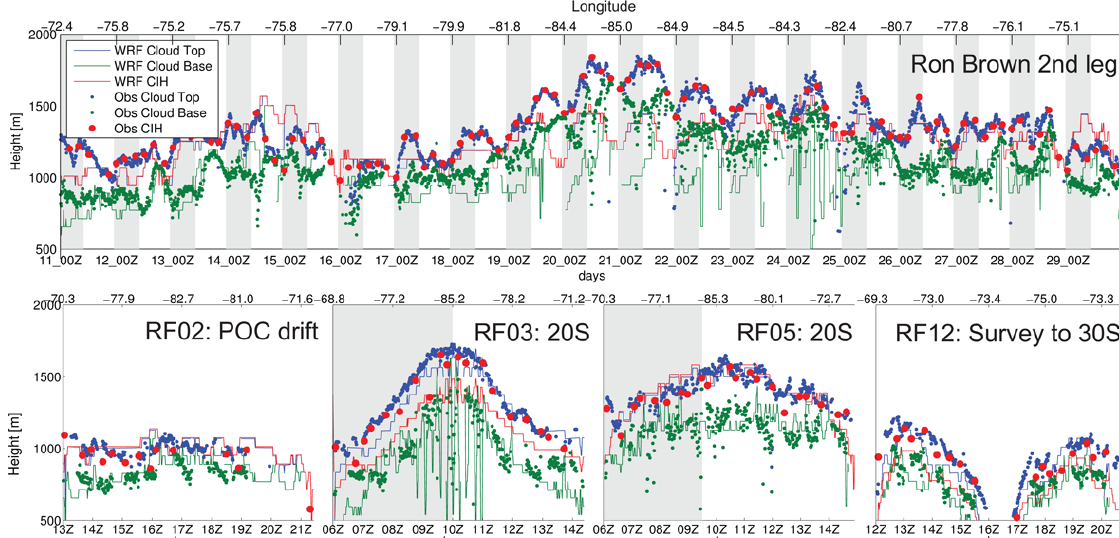
Fig. 4. Observed and NW model cloud bottom, cloud top and capping inversion height (CIH) time series from Ron Brown (top) and four C-130 flights (bottom). Shaded areas represent night